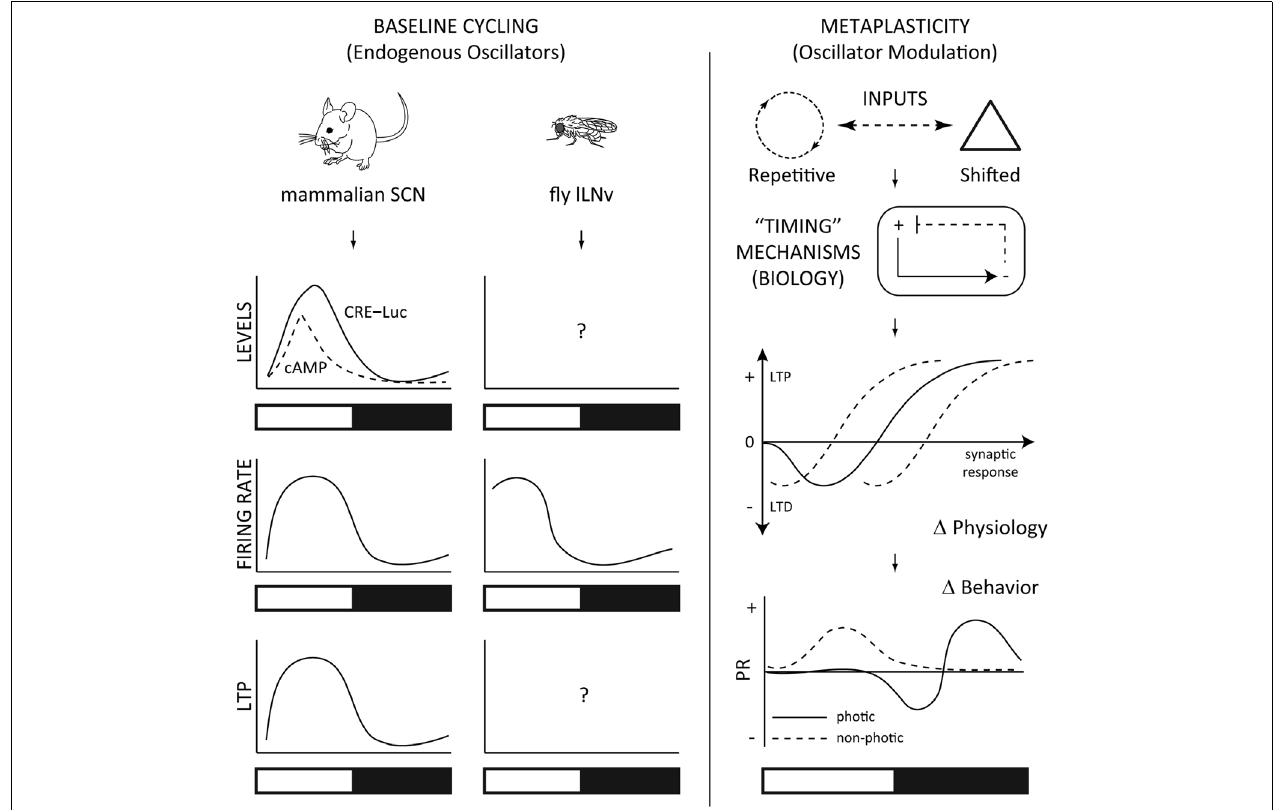
Changes in cycling environmental inputs signal to the organism’s timing mechanisms, and integrates the incoming signal with the endogenous oscillators, engaging adaptive and resistant molecular and cellular processes. These biological processes confer a neurophysiological correlate in the neural network in the metaplastic synaptic response, which in turn generates a “metaplastic” change in behavior, based on the time-of-day. A typical phase-response (PR) curve is shown for photic and non-photic stimulation (Golombek and Rosenstein, 2010).This scheme can be generalized to more complex cognitive processes, such as hippocampal molecular signaling, synaptic plasticity and memory, which also display time-of-day dependent changes in cAMP/MAPK/CREB activity, LTP and fear conditioning (Gerstner andYin,